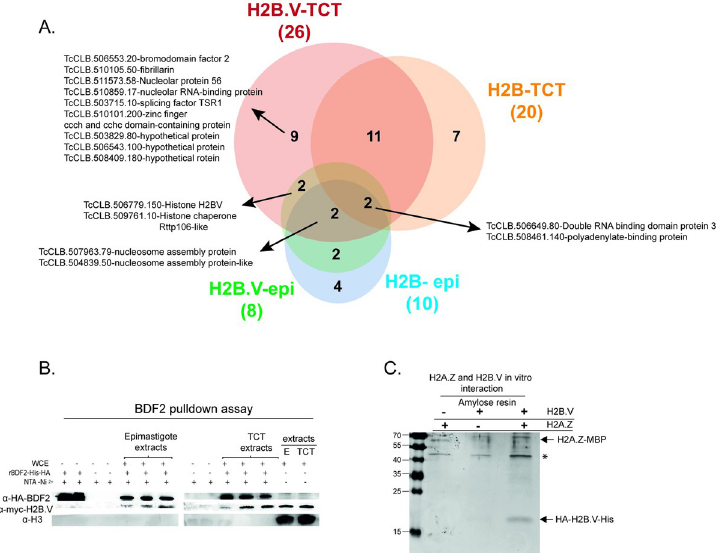
Fig 3. H2B.V in vitro interactors. A. Venn diagram showing the number of common and specific interactors of H2B. V and H2B using epimastigote and TCT extracts. The total number of eluted proteins in each pulldown is shown between parentheses. Some relevant proteins are highlighted. B. BDF2 pulldown assays. Recombinant BDF2 tagged with HA and 6xHis was incubated with NTA-Ni resins with or without H2B.V-myc-tagged parasite extracts (epimastigotes or TCTs). Eluates were fractionated by 15% SDS-PAGE, and protein interactors were revealed by WB with anti-HA (against rBDF2), anti-myc (against H2B. V-myc tagged), and anti-H3 (as a chromatin control). C. H2A. Z interacts with H2B.V in vitro . H2A.Z-MBP and H2B.V-6xHis recombinants were incubated together or separately with amylose resin, known to specifically interact with MBP. Eluates were fractionated by 15% SDS-PAGE and stained with Coomassie. H2A.Z-MBP is approximately 60 kDa, and H2B.V-6xHis is 16.5 kDa. The � indicates a contaminant of lysed